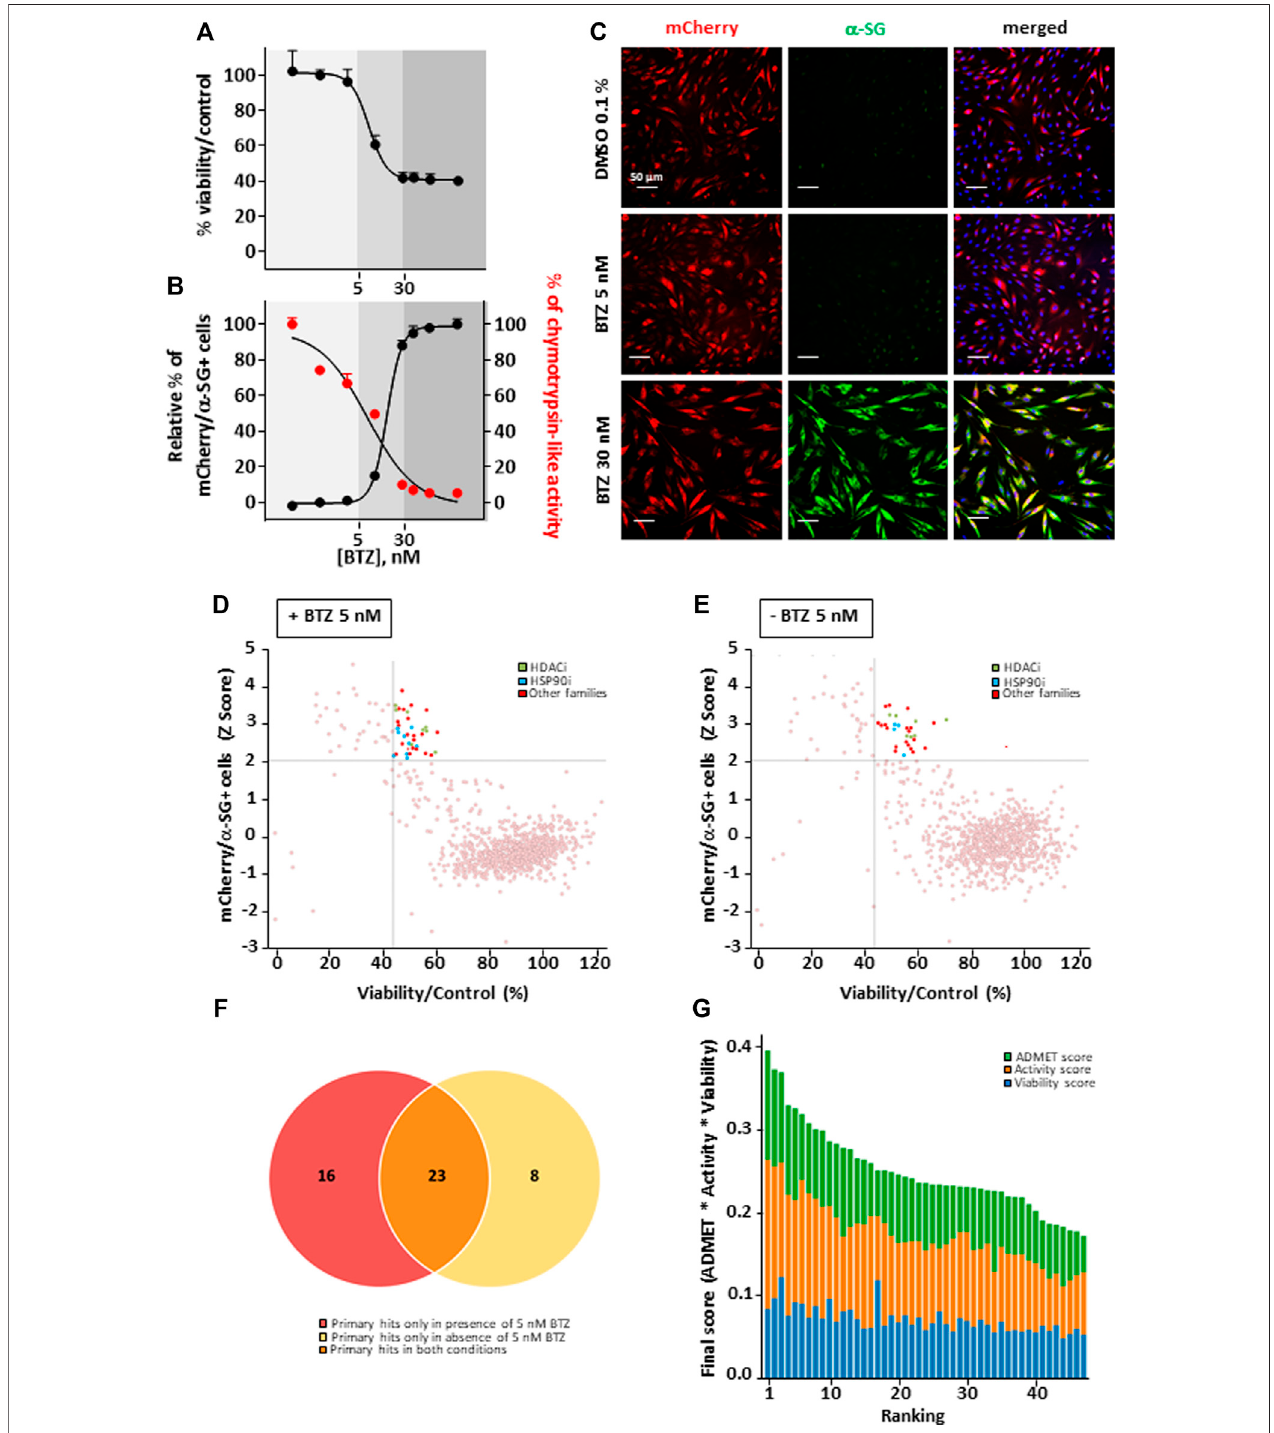
FIGURE 1 | Combinatorial high-content screening for R77C- α -SGmCh membrane rescue. (A,B) Cell viability (A) , chymotrypsin-like activity of the proteasome and quanti fi cationofmCherryandmembrane α -SGpositive fi broblasts (B) followingtreatmentwithincreasingconcentrationsofBTZ.Eachpointrepresentsthemean±SD( n =4)ofa representative experiment over three independent experiments. (C) mCherry fl uorescent signal (red) and α -SG staining (green) in non-permeabilized condition in fi broblasts overexpressing R77C- α -SGmCh treated with 0.1% DMSO, 5 nM or 30 nM BTZ. Nuclei are labelled by Hoechst staining (blue). Scale bar = 50 µm. (D – E) Dot plot representationsoftheeffectsofthe958drugsat5 µMincombinationwith5 nM (D) oralone (E) onR77C α -SGmChmembraneexpression(Zscore > 2)andcellviability(viability > 45%).Hitsarecoloredaccordingtotheircompoundfamilies,HDACiaregreen,HSP90iareblueandotherfamiliesarered. (F) Venndiagramillustratingthenumberofprimaryhits onlyinpresenceof5 nMBTZ(red),onlyinabsenceof5 nMBTZ(yellow)orinbothconditions(orange). (G) Classi fi cationofhitcompoundsbasedonavirtualADMETanalysisusing arti fi cialintelligence.The fi nalscorecomprisedtheADMETscore(green),theactivityscore(orange)andtheviabilityscore(blue)determinedduringthescreening.BTZ,bortezomib.